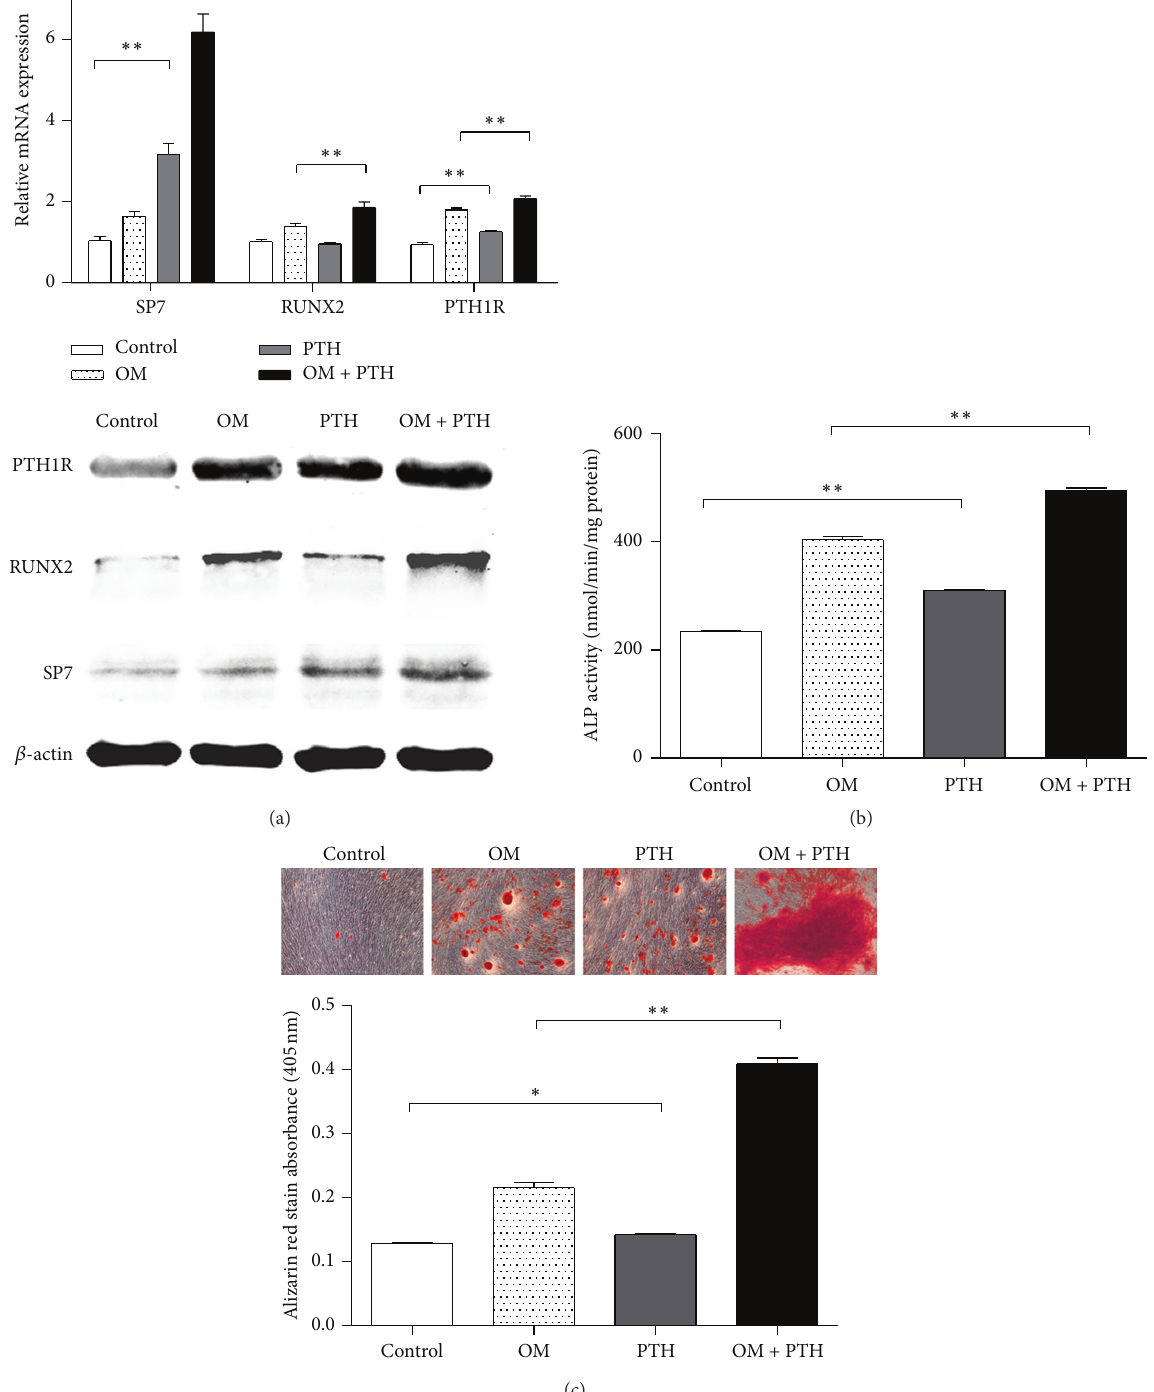
Figure 4: The osteogenic capacity of STRO-1(+) hPDLSCs was enhanced by PTH. (a) Real-time PCR and western blot analyses of PTH1R, RUNX2, and SP7 expression in STRO-1(+) hPDLSCs before and after PTH treatment and induction by osteogenic-induction medium (OM). The expression of each target was normalized to that of GAPDH. (b) ALP activity in STRO-1(+) hPDLSCs. (c) Cells subjected to osteogenic differentiation were stained with Alizarin red (magnification: 100x). Data are presented as the means ± SDs of three independent experiments performed in duplicate. ∗ 𝑃 < 0.05 , ∗∗ 𝑃 < 0.01